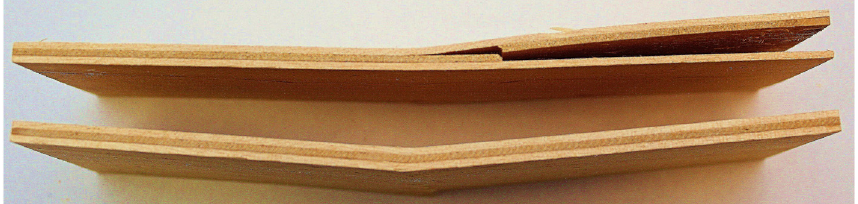
Figure 7. The image of samples after bending test: REF 0 delamination in bonding line ( top ) and REF 10 bottom layer break ( bottom ).